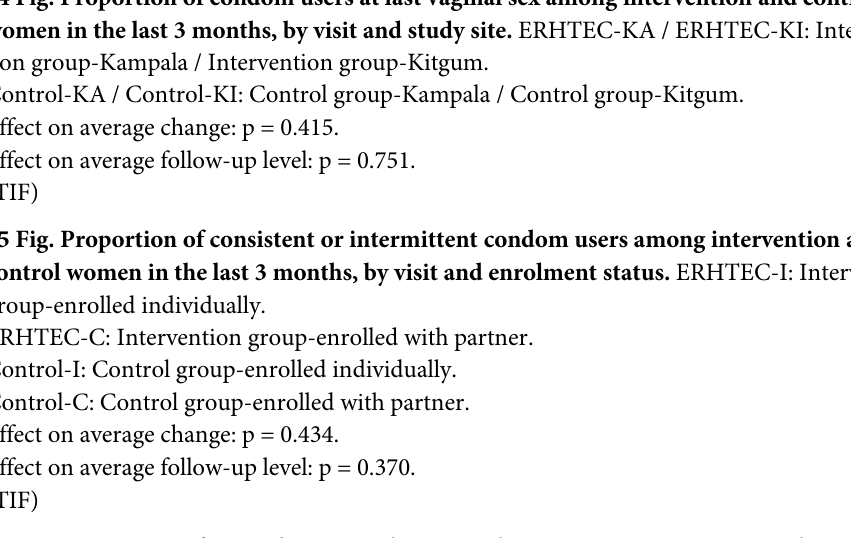
S6 Fig. Proportion of vaginal sex episodes w/ condoms among intervention and control women in the last 3 months, by visit and enrolment status. ERHTEC-I: Intervention group- enrolled individually.